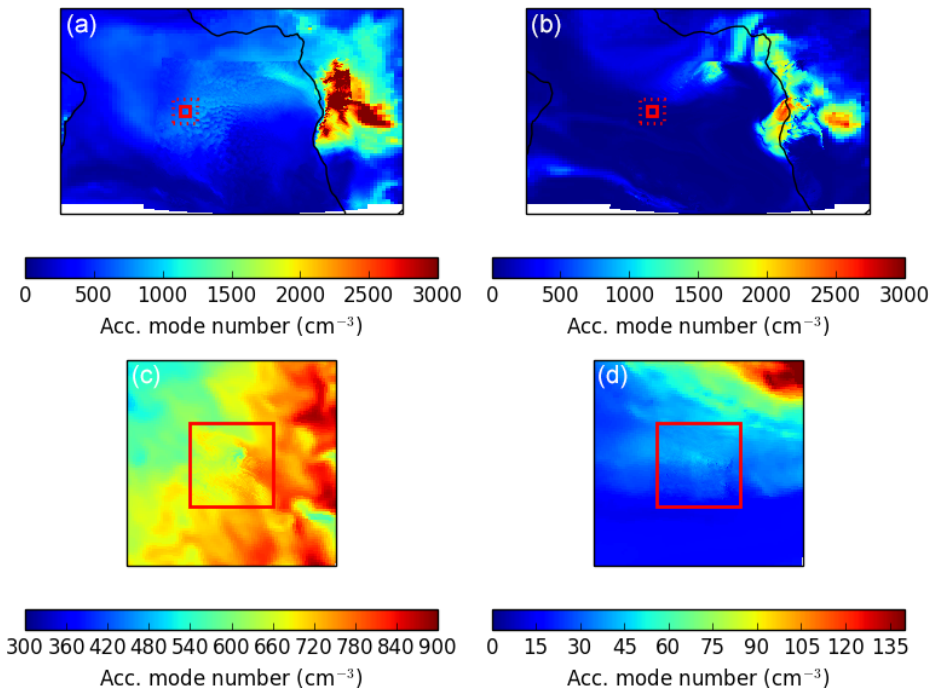
Figure 2. Simulated number concentration of accumulation-mode aerosol (abbreviated as “Acc. mode” in the legend labels) in the boundary layer (averaged from the surface to 750m altitude) on the left and in the lower free troposphere (averaged from 2900 to 3400m altitude) on the right (in cm − 3 ) at midday UTC on 19 August. The 500m regional domain is shown as a red square on all four plots; the plots (a, b) show the global and 7km models with the domain of the plots (c, d) as a red dotted square, while panels (c, d) show the 7km model and the 500m